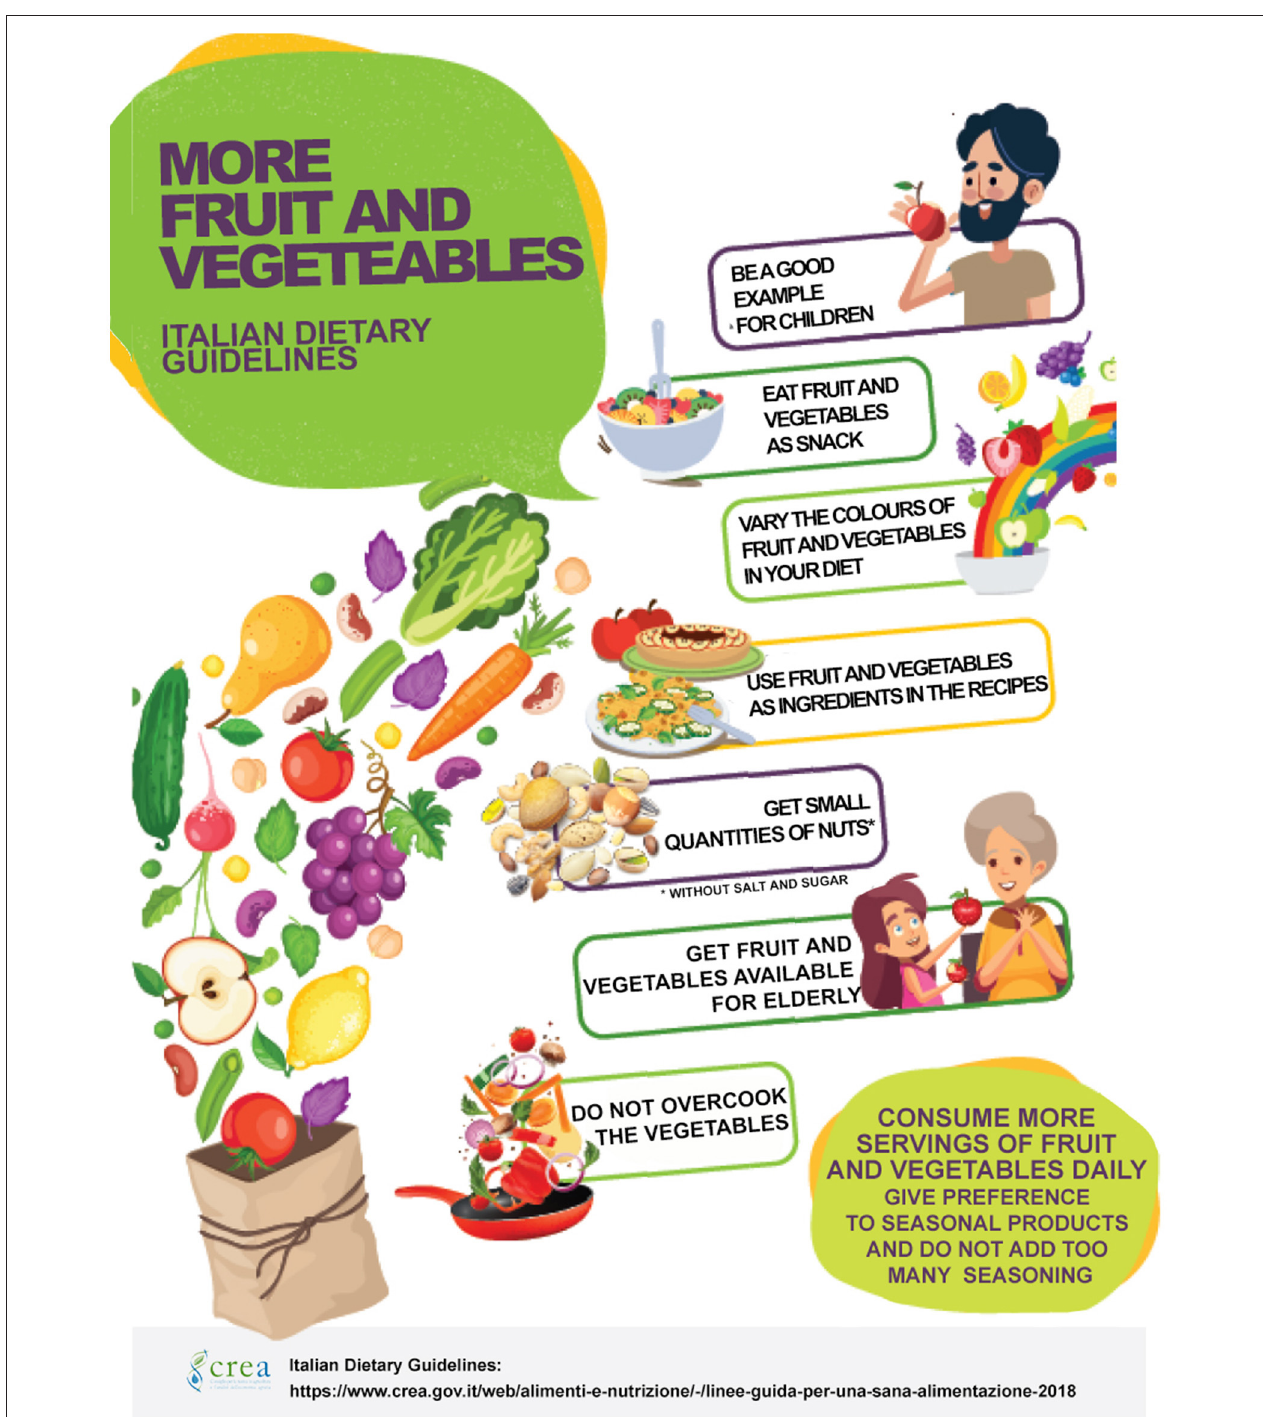
FIGURE 4 | The decalogue for promotion of fruit and vegetable consumption.